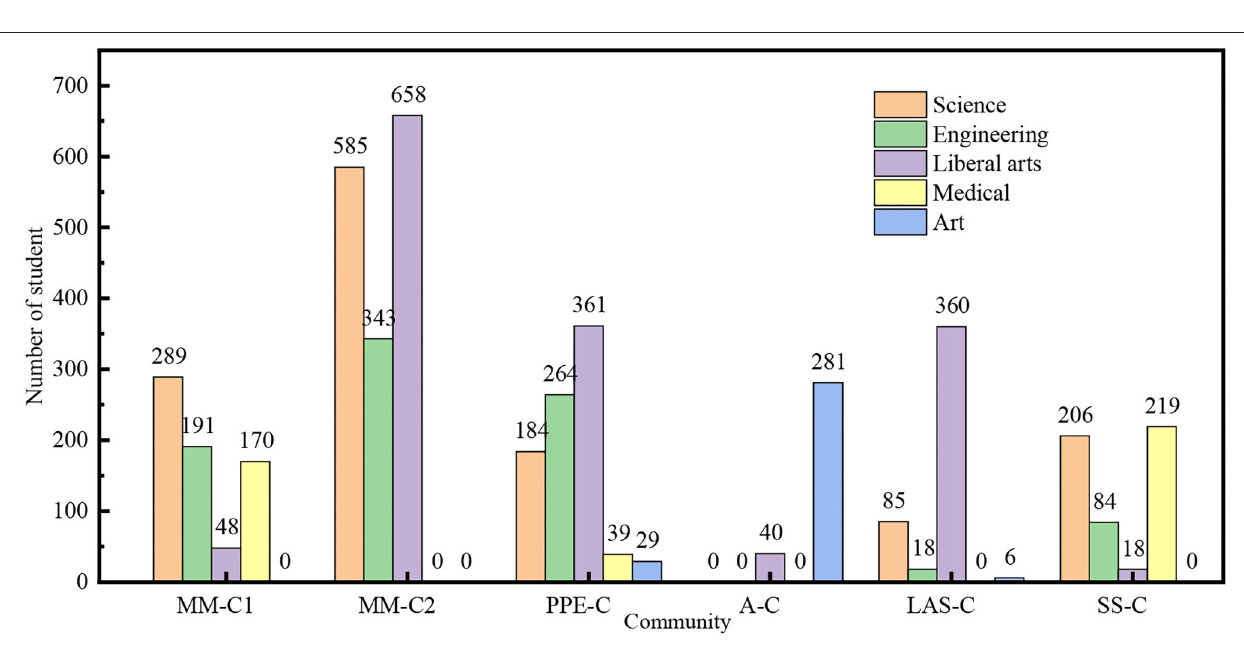
FIGURE 4 | Major distribution in the